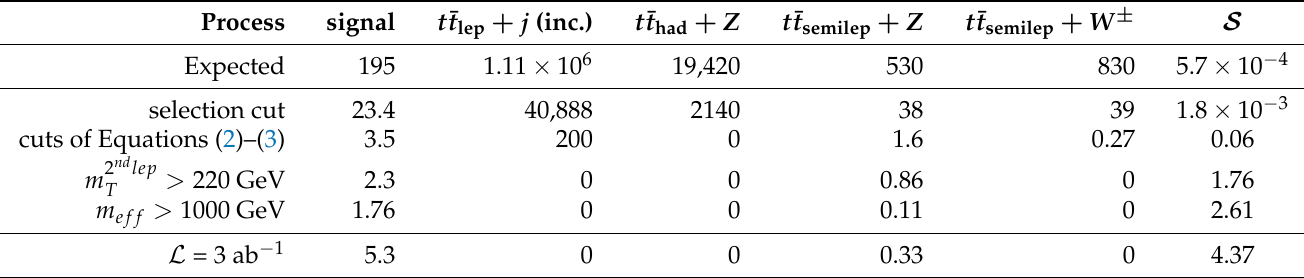
Table 2. Cut flow with L = 1 ab − 1 corresponding to the Right case signal production. The last column is the significance with a systematic uncertainty in the background of 30%. The last row is the projection to L = 3 ab − 1